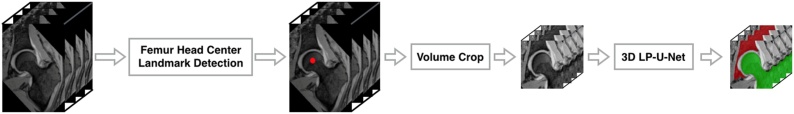
A schematic illustration of the two-stage deep learning based method for fully automatic hip MRI joint segmentation. The femoral head center is detected by the landmark detection network, and then we crop the hip joint data around the femoral head center. Finally the LP-U-Net is applied to segment the cropped hip joint.